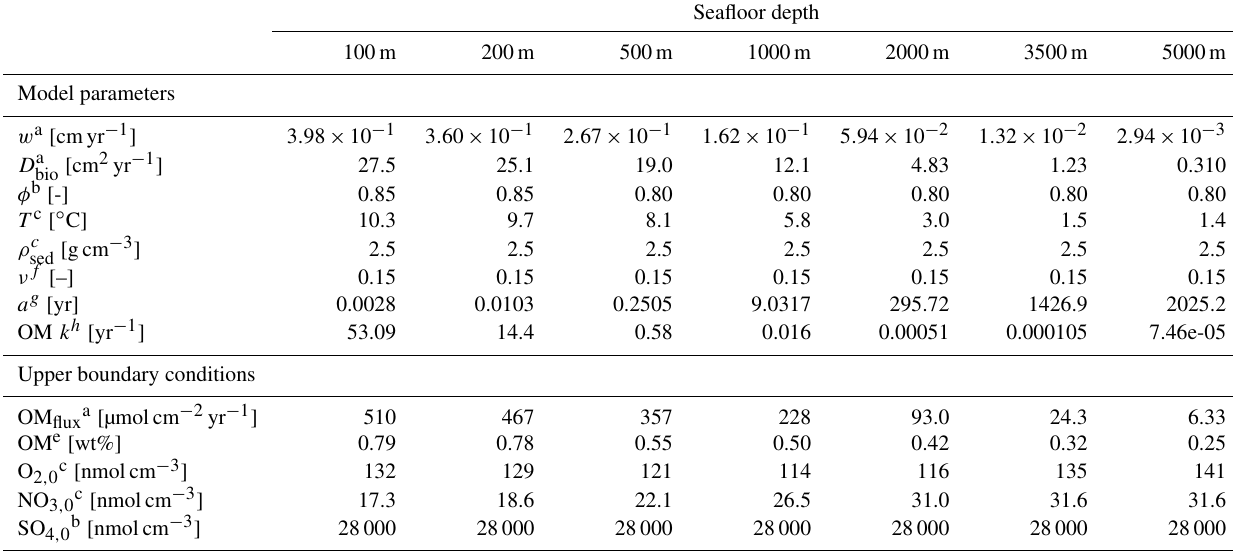
Table 2. Seafloor depth dependency of key model parameters and boundary conditions (adapted from Thullner et al.,